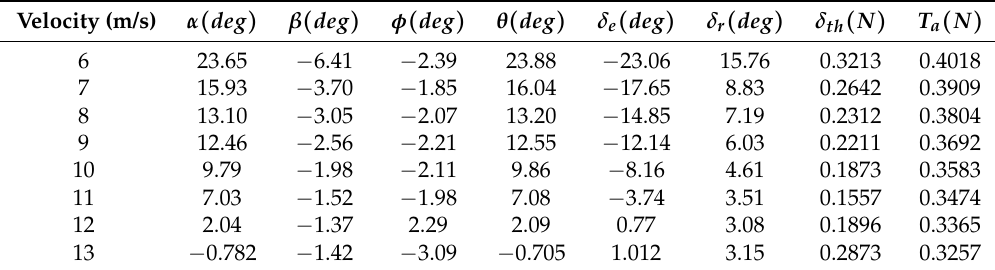
Table 9. Trim conditions of